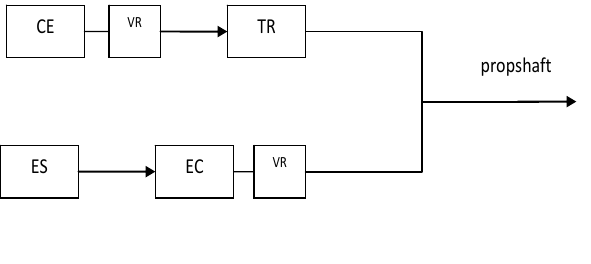
Figure 8. Structure of the Parallel system considered in the experiment. The letters indicate: CE: Internal combustion engine, EC: Energy conversion unit (Motor/Generator), ES: Energy storage unit (Battery), TR: Transmission, VR: Variable Reluctance sensor and its signal processing